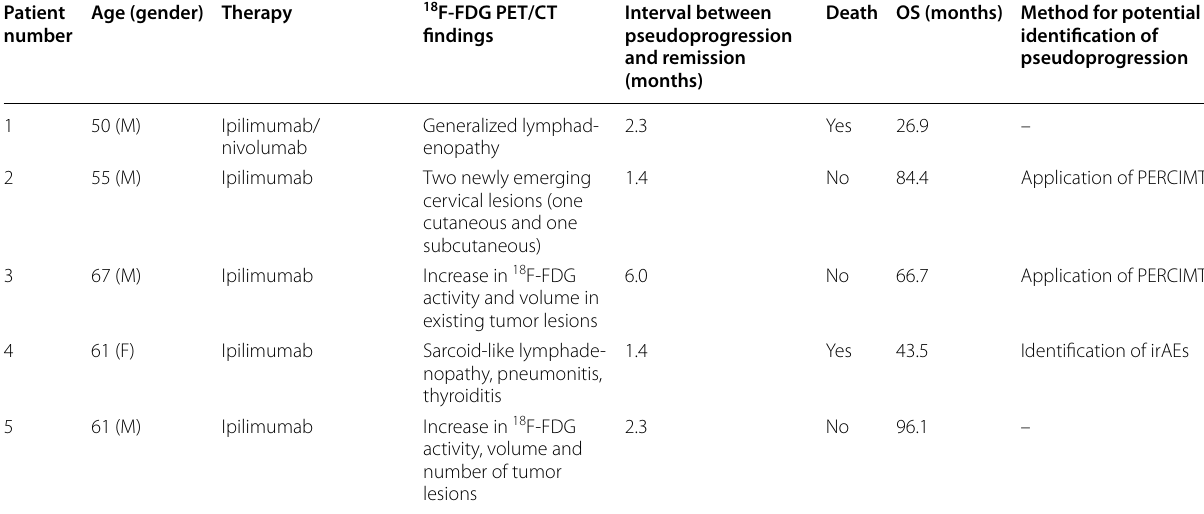
F, female; M, male; ICIs, immune checkpoint inhibitors; OS, overall survival; PERCIMT, PET Response Evaluation Criteria for Immunotherapy; irAEs, immune-related adverse-events